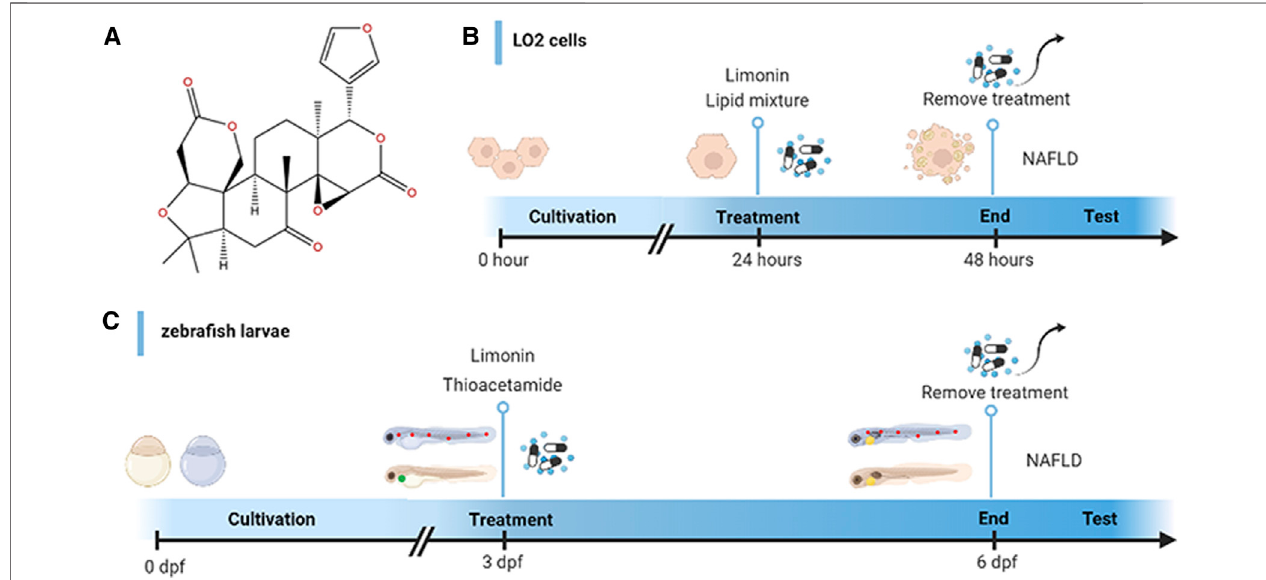
FIGURE 1 | Design of experimental process. (A) Chemical structure of limonin. (B) Schematic diagram of drug treatment for LO2 cells. (C) Schematic diagram of drug treatment for zebra fi sh.